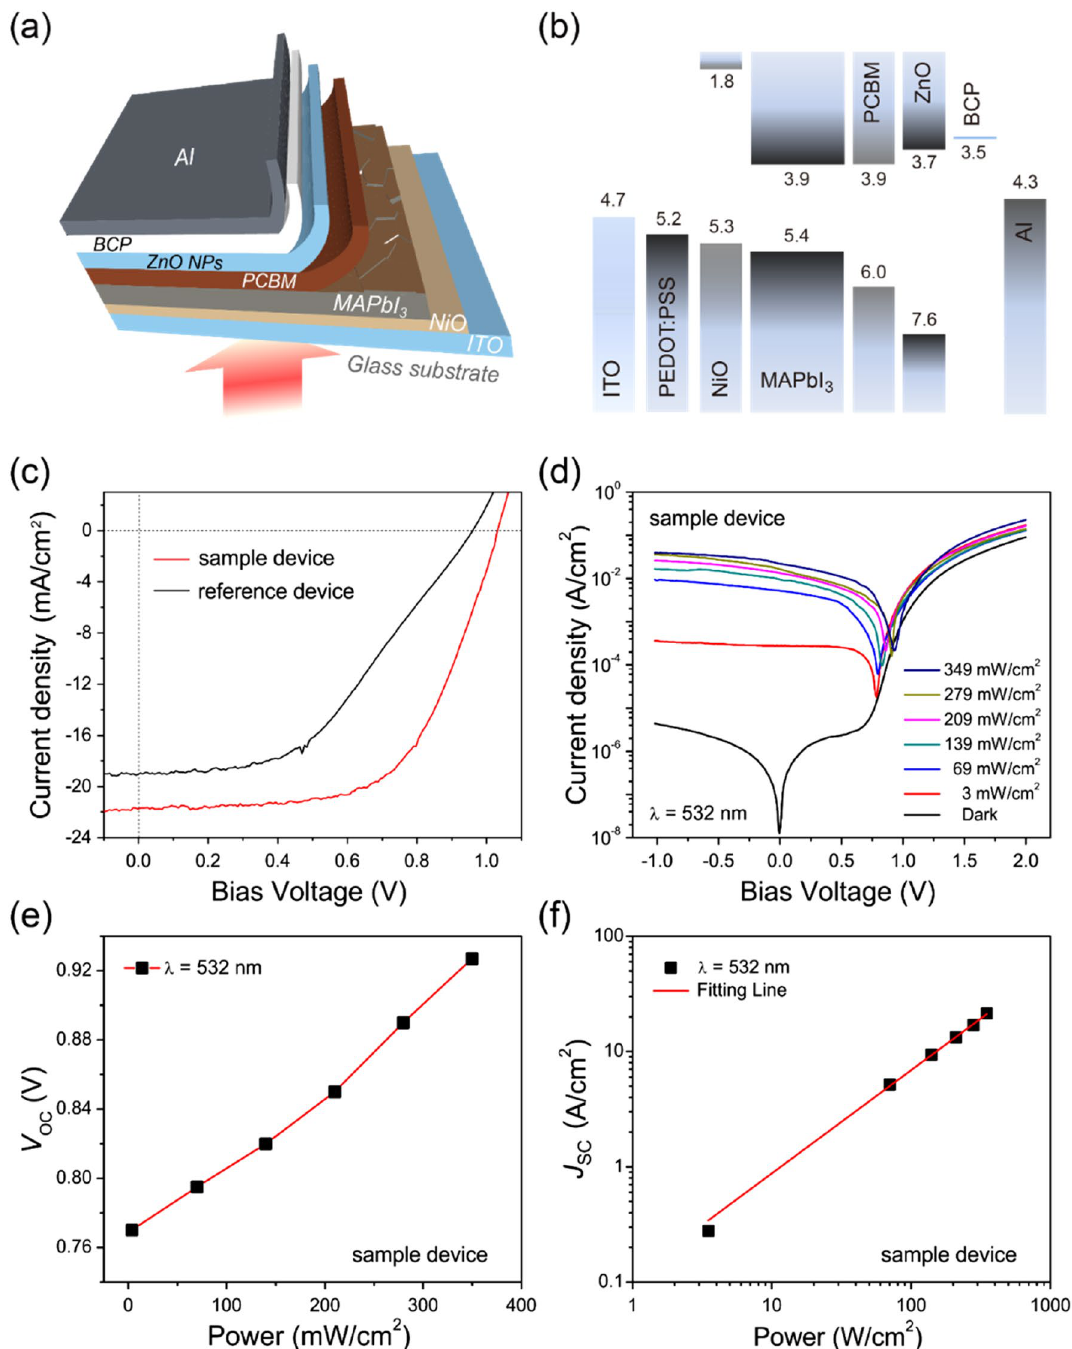
Figure 4. ( a ) Schematic diagram of a self-powered perovskite photodiode with NiO x as an electron-blocking and HTL, ( b ) energy band diagram of the self-powered perovskite photodiode, ( c ) photovoltaic measurements of the perovskite photodiodes under an AM1.5G illumination source, ( d ) photocurrent density of the perovskite photodiode with the NiO x HTL as a function of the bias voltage for several different intensity levels of incident light with a wavelength of 532 nm, ( e ) open-circuit voltage ( V oc ) of the photodiode with the NiO x HTL as a function of the input power of the incident laser light, and ( f ) short-circuit current density ( J sc ) of the photodiode with the NiO x HTL as a function of the input power of incident light (532 nm) at zero bias